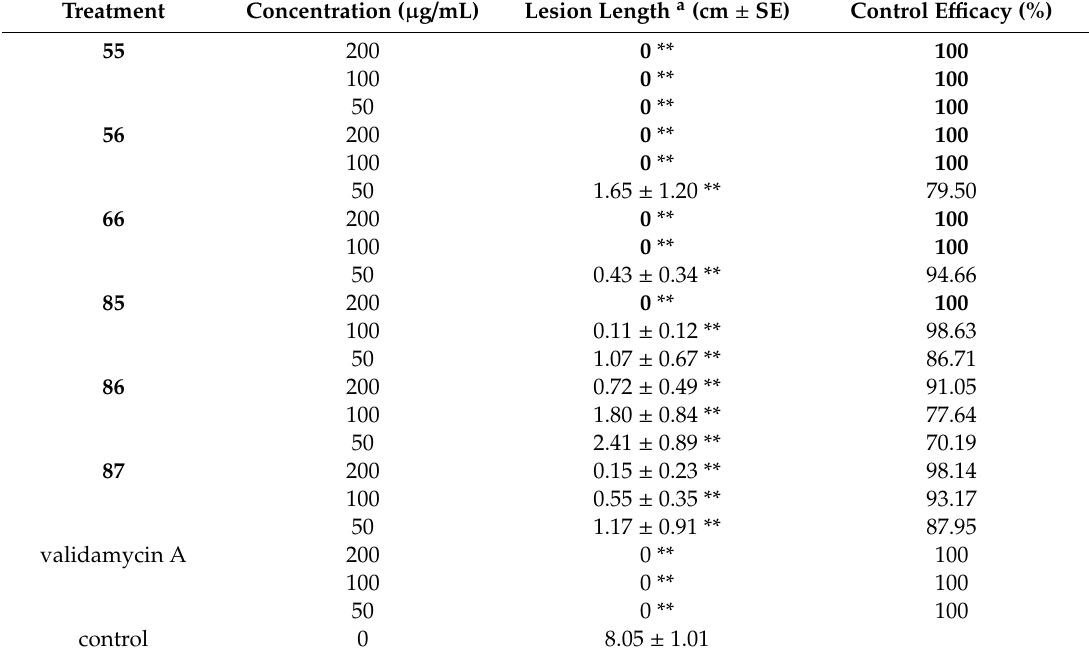
Table 5. In vivo protective activity against R. solani using detached leaf assay.